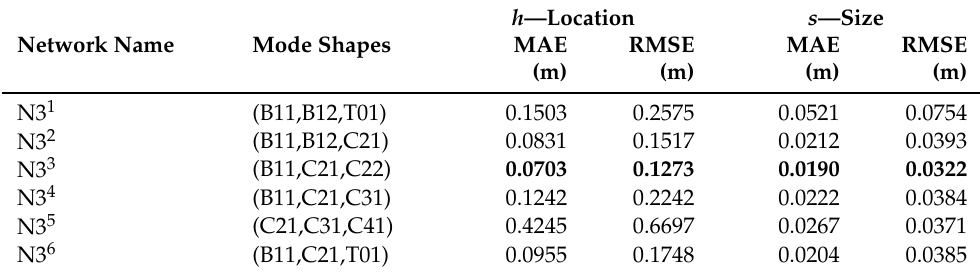
Table 6. The results of the identification of { h , s } on the basis of three mode shapes.